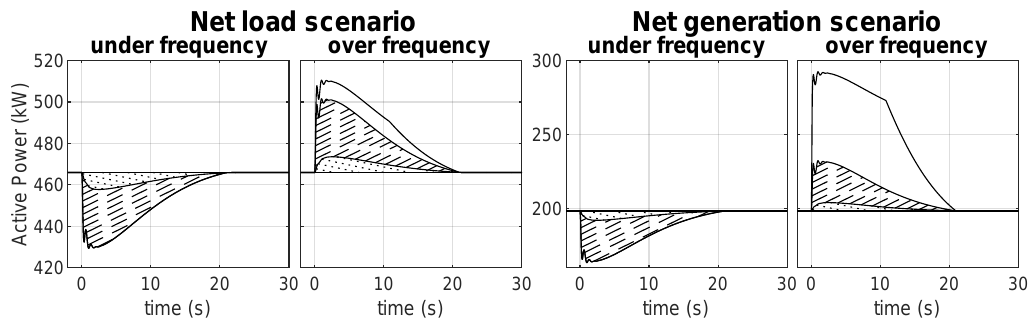
Figure 21. Active power consumption variation in the AC LV network due to load voltage sensitivity (dotted area), controllable energy storage (dashed area) and controllable PV generation (white area). Positive values correspond to power consumption.